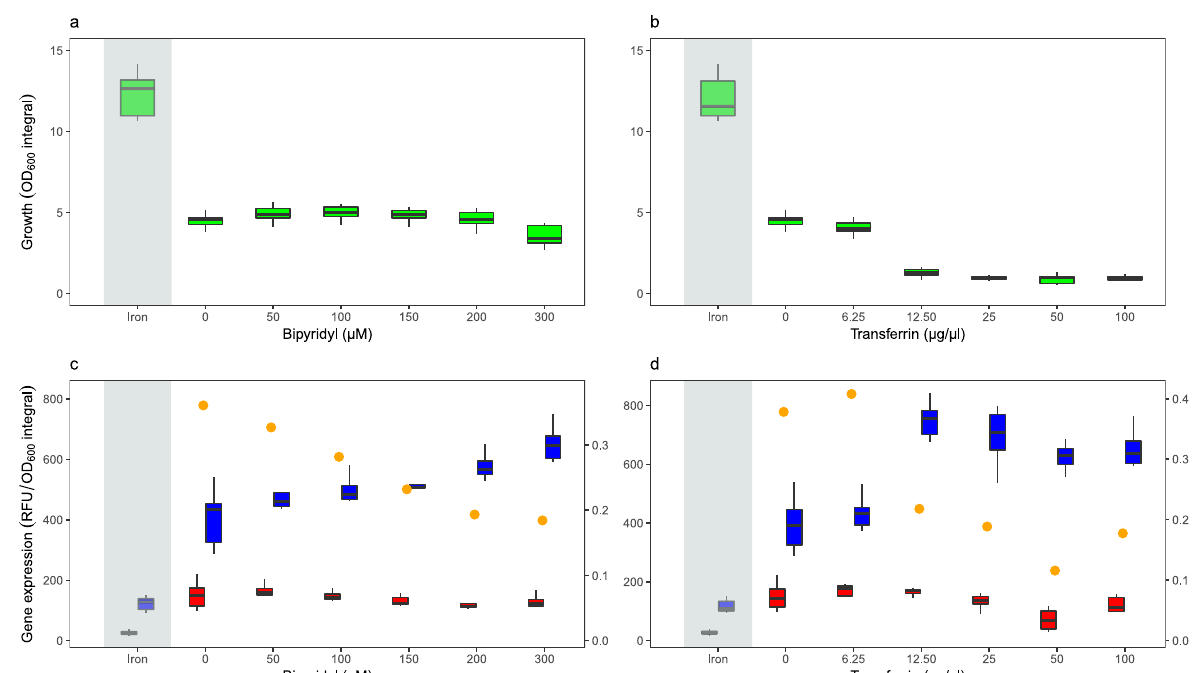
Fig. 1 Higher levels of iron limitation reduce population growth and induce a relative increase of pyoverdine versus pyochelin gene expression in P. aeruginosa . a , b Growth measured as integral (area under the OD600 curve) over 24 h batch culture experiments in iron-replete CAA medium (100 µ M FeCl 3 , grey shaded area) and CAA media with increasing concentrations of the iron chelators bipyridyl ( a ) and human apo-transferrin ( b ). Higher iron chelator concentrations in the medium signi fi cantly reduced bacterial growth (see Table S1 for statistics). c , d Siderophore reporter gene expression (red: pyochelin PAO1 pchEF : mcherry ; blue: pyoverdine PAO1 pvdA : mcherry ) measured as normalized integral (area under the relative fl uorescence unit (RFU) curve divided by the OD600 integral) over 24 h batch culture experiments. Gene expression was measured in iron-replete CAA medium (100 µ M FeCl 3 , grey shaded area) and CAA media with increasing concentrations of the iron chelators bipyridyl ( c ) and human apo-transferrin ( d ). Relative gene expression was measured as the ratio of normalized pyochelin to pyoverdine expression (yellow dots). Boxplots represent the median with 25th and 75th percentiles, and whiskers show the 1.5 interquartile